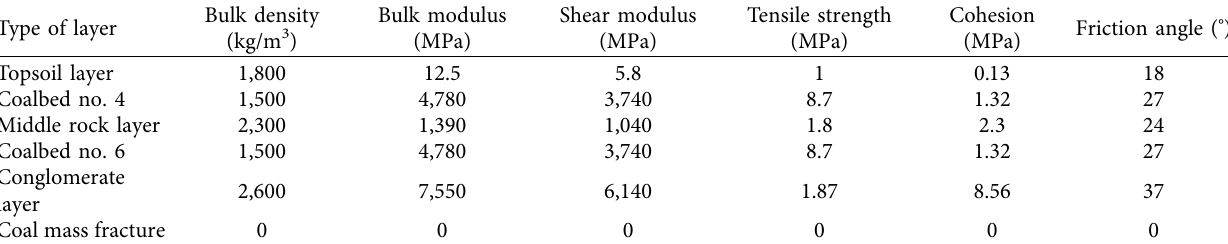
Figure 9: Cloud chart of vertical displacement for the slope after fracturing. Table 5: Material parameters of the geological